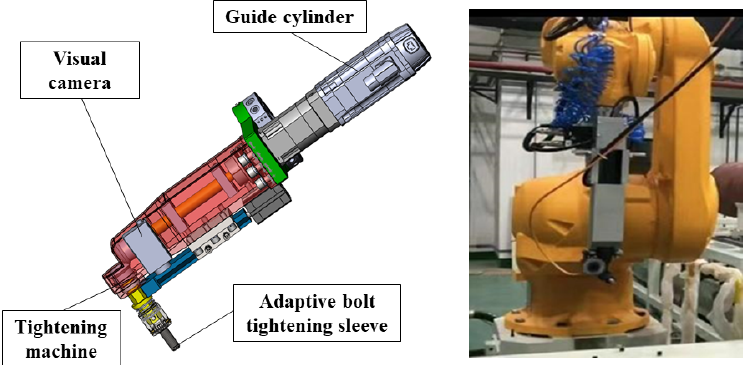
Figure 3. Bolt tightening tool.